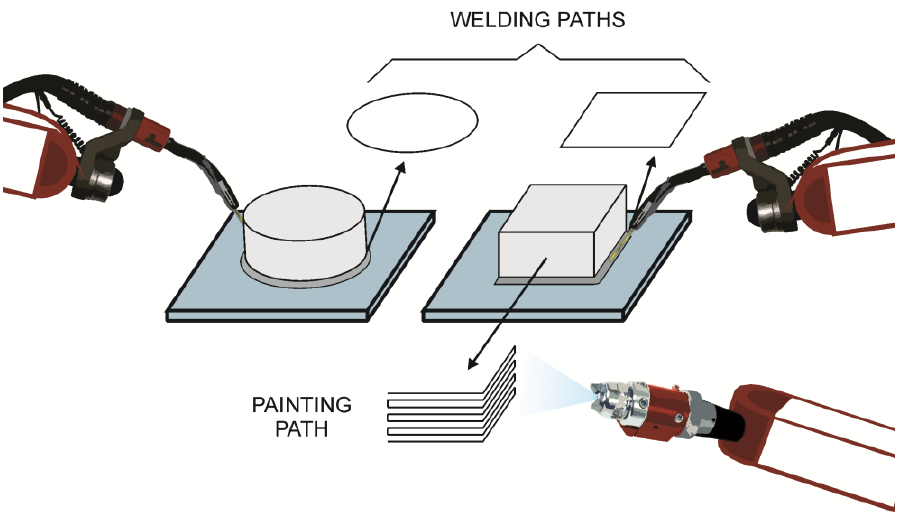
Figure 6. Real-operation-oriented